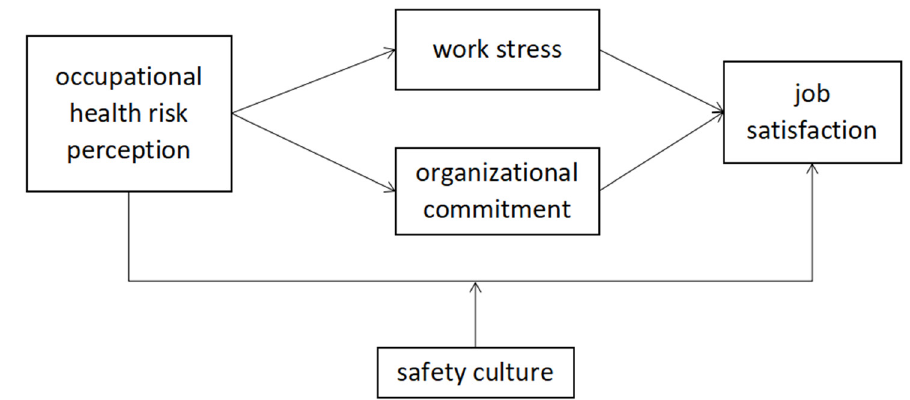
Figure 1. Research